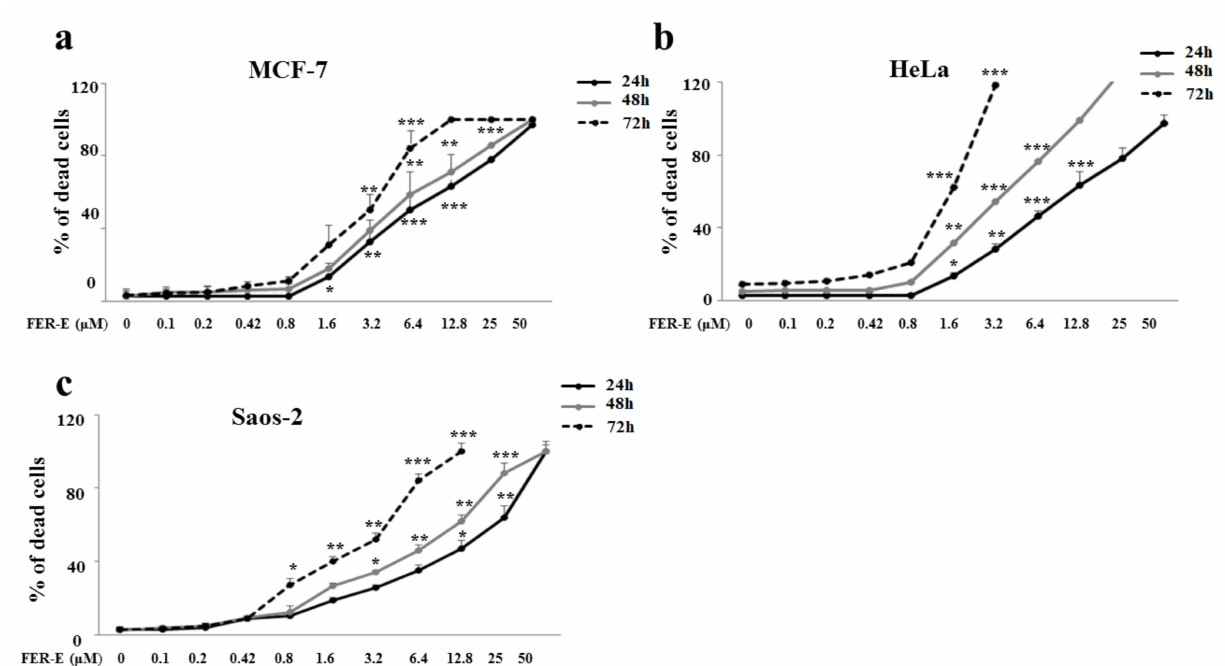
Figure 5. Percentage of mortality induced by treatment with FER-E. Percentage of mortality was calculated following treatment with FER-E for 24, 48 and 72 h by the Trypan blue test. In particular, mortality induced by treatment with FER-E on MCF-7, HeLa and Saos-2 cell lines was shown in panels ( a – c ), respectively. Three independent experiments were carried out, and the values are expressed as the mean ± standard deviation (sd). * denotes p < 0.05 versus the control; ** denotes p < 0.01 versus the control; *** denotes p < 0.001 versus the control. Analysis of Variance